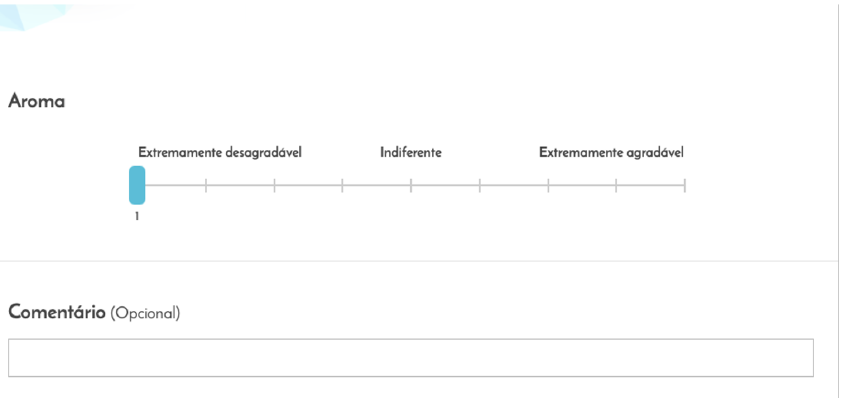
Figure A1. Example of acceptance question of the protocol using an 9-point hedonic scale concerning aroma. Translation from top to bottom: ‘Aroma’, ‘Extremely unpleasant’, ‘Indifferent’, ‘Extremely pleasant’, ‘Comments (optional)’.